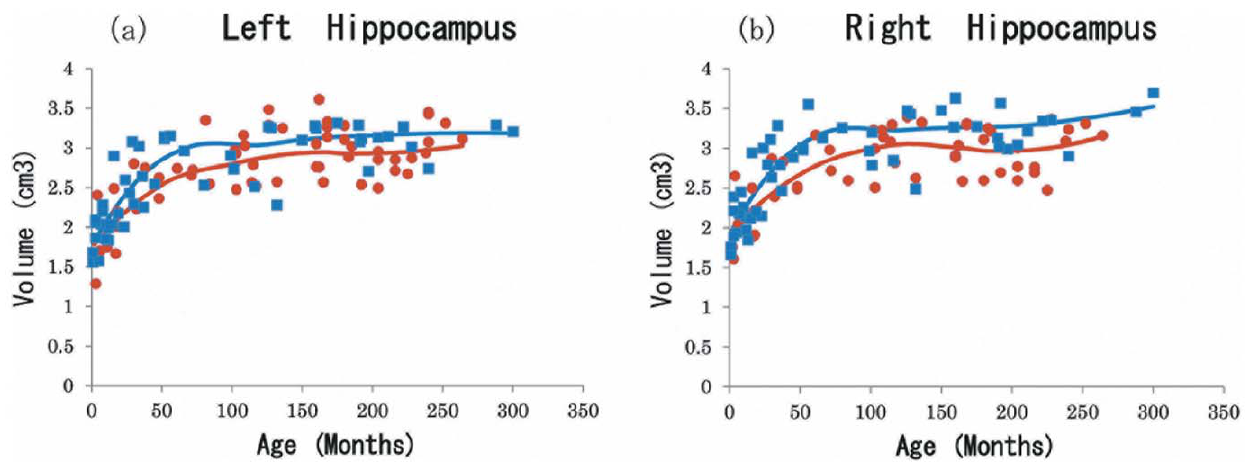
Figure 3. Scatterplots by monthly age and sex of absolute left and right hippocampal volume with locally weighted scatterplot smoothness (LOWESS). (a); LH: left hippocampus, (b); RH: right hippocampus, blue square: male (n=57), red circle: female (n=52), blue line: males’ LOWESS, red line: females’ LOWESS.